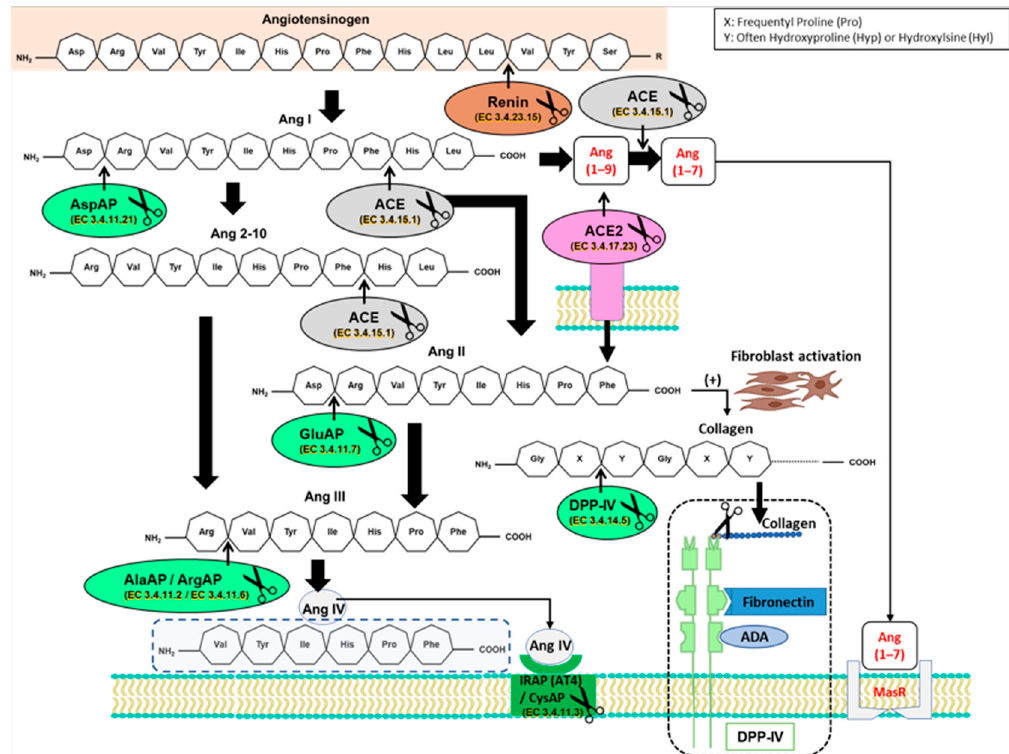
Figure 1. Partial diagram of angiotensinase activity downstream of the classical axis of the renin–angiotensin system (RAS) and the ACE2/Ang (1–7)/Mas receptor pathway, displaying the metabolic steps in which angiotensinase activities are involved. Ang II stimulates fibroblasts to produce collagen, this being a substrate for dipeptidyl peptidase IV (DPP-IV). ACE: angiotensin-converting enzyme; ACE2: angiotensin-converting enzyme 2; ADA: adenosine desaminase; AlaAP: alanyl aminopeptidase; Ang I: angiotensin I; Ang (1–7): angiotensin (1–7); Ang (1–9): angiotensin (1–9); Ang 2–10: angiotensin 2–10; Ang II: angiotensin II; Ang III: angiotensin III; Ang IV: angiotensin IV; ArgAP: arginyl aminopeptidase; AspAP: aspartyl aminopeptidase; AT4: angiotensin AT4 receptor; GluAP: glutamyl aminopeptidase; IRAP/CysAP: insulin-regulated aminopeptidase activity/cystinyl aminopeptidase; MasR: Mas receptor. The scissors symbol represents proteolytic activity of the enzyme, cleaving amino acids from the amino terminals.